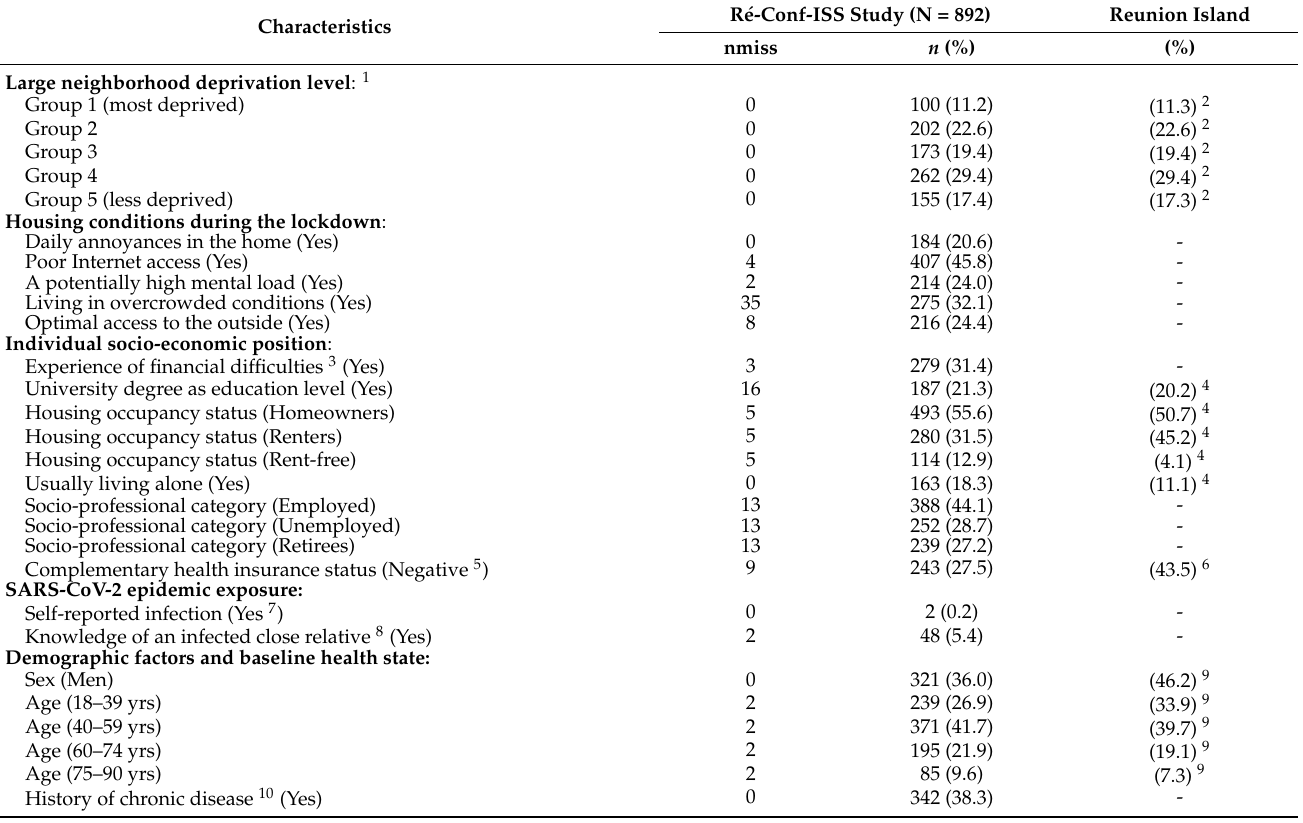
Table 1. Exposure factors, demographic factors, baseline health state in the R é -Conf-ISS study population and regional